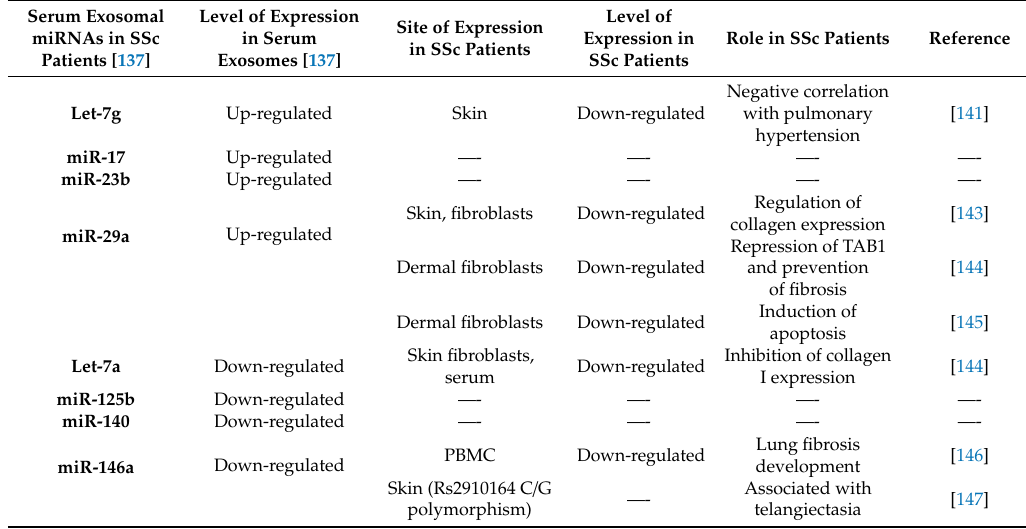
Table 1. Comparison of the exosomal miRNAs identified by Wermuth PJ et al. in the serum of SSc patients and their possible role in systemic